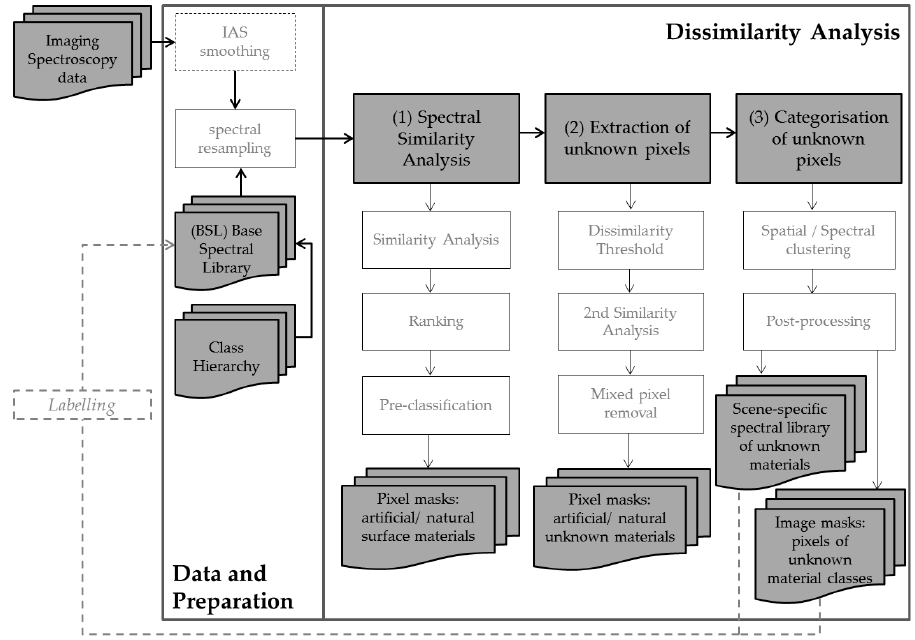
Figure 1. Basic concept of a spectral dissimilarity analysis to detect unknown urban surface materials in high-resolution airborne imaging spectroscopy data.